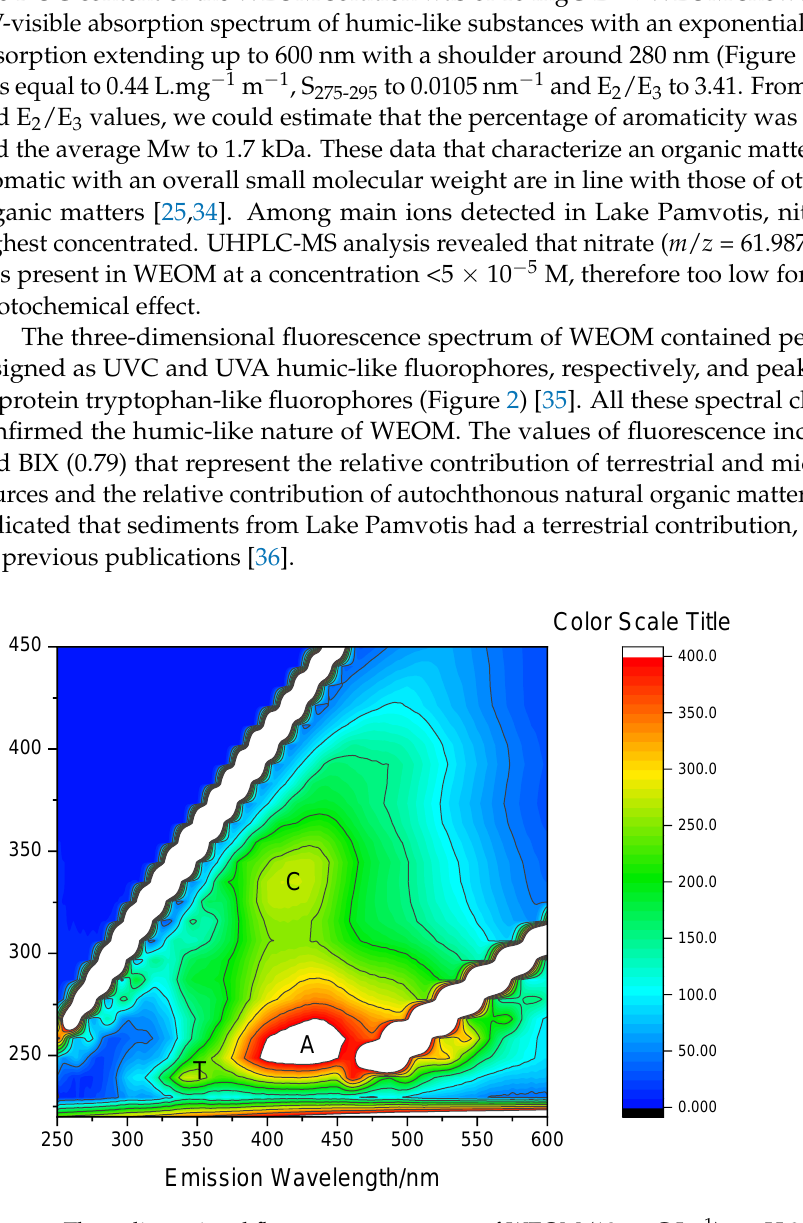
Figure 2. Three dimensional fluorescence spectrum of WEOM (18 mgC L − 1 ) at pH 9.2.